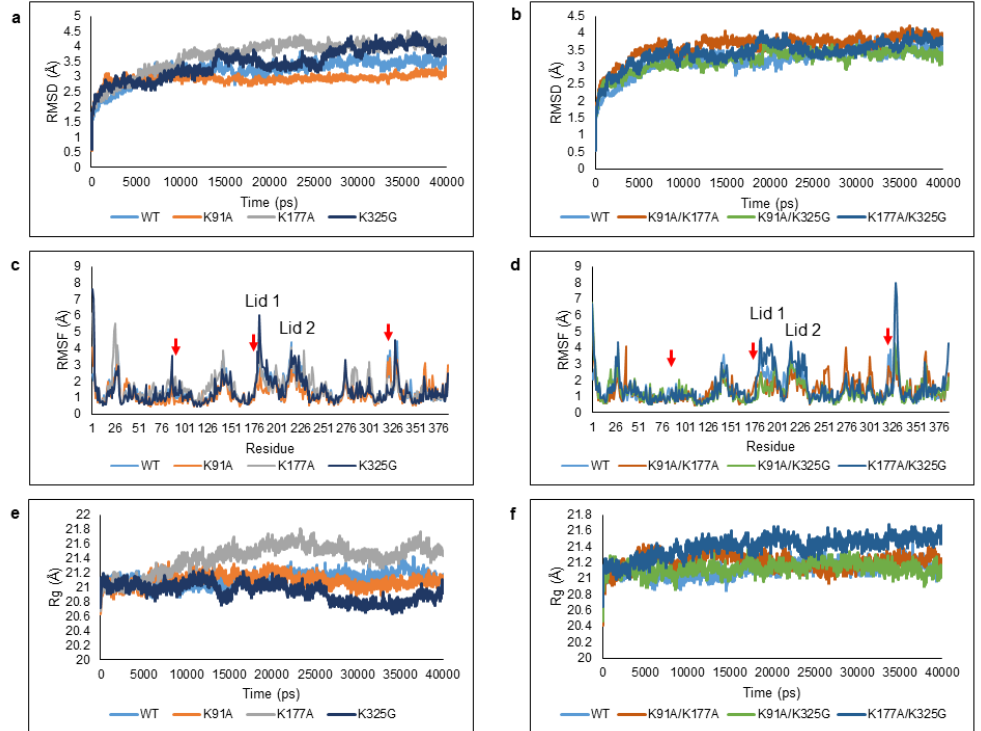
Figure 3. Deviations and fluctuations of the WT and mutant lipases when simulated in an aqueous environment. Trajectories of WT and mutant lipases were represented in different colour; ( a , b ) Root Mean Square Deviation (RMSD), ( c , d ) Root Mean Square Fluctuation (RMSF), and ( e , f ) Radius of gyration (Rg). The red arrows represent the position of K91, K177, and K325 in the RMSF